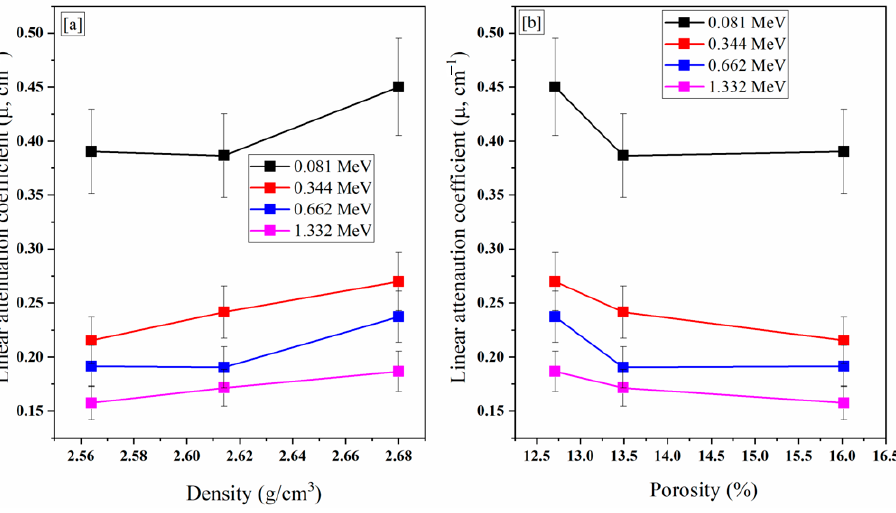
Figure 5. The variation of the µ values as a function ( a ) concrete density and ( b ) concrete